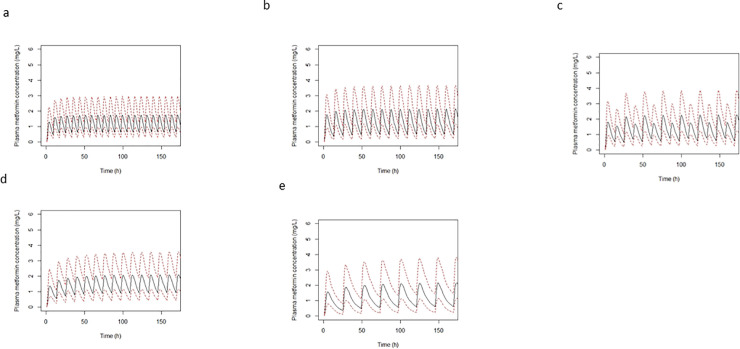
Simulated plasma metformin concentration versus time profiles for select doses in each kidney function band (immediate release formulation); (a) 750 mg TID normal kidney function, (b) 850 mg BID CKD2, (c) 750 mg mane, 500 mg nocte, CKD3a, (d) 500 mg BD, CKD3b, (e) 500 mg OD CKD4.